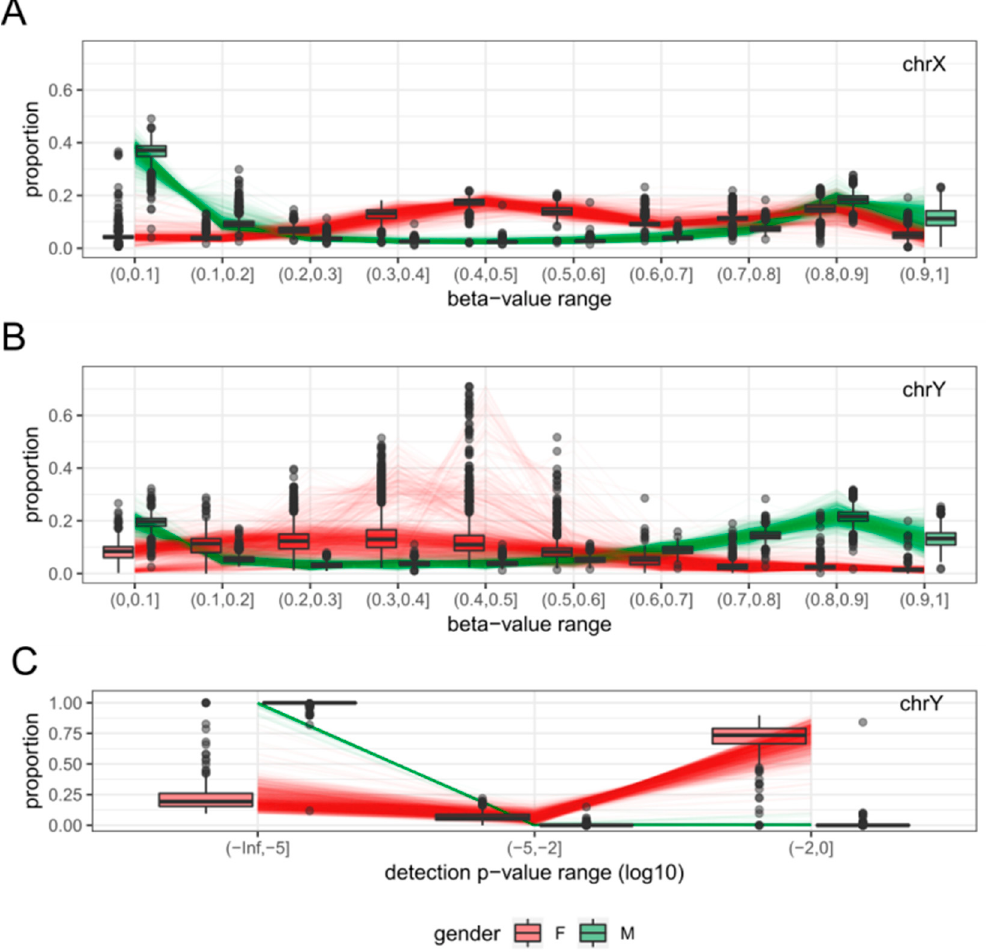
Figure 1. Distinct distributions of methylation levels and confidence measures at the sex chromosomes. Distribution profiles were generated from 1000 male and 1000 female samples randomly selected from 12 GEO datasets (See Materials and Methods for details). Each line represents the distribution profiles of male (green line) or female (red line), but the color was blurred in order to enhance the visibility of boxplot. ( A ) While the beta-value distribution on chrX of male samples is similar to the overall beta-value distribution for the whole genome (not shown), that of female samples is vastly different. ( B ) The beta-value distribution for male chrY is also similar to the genome-wide beta-value distribution, but its female counterpart is difficult to characterise because probes targeting chrY cannot yield credible signals from female samples. ( C ) The vast majority of chrY probes exhibit very low detection p -values for male samples, but the opposite is true for female samples. Table 1. Comparison of clustering results and labelled sex for 2000 randomly selected samples. Cluster by PCA.X/Cluster by PCA.Y Labelled Sex